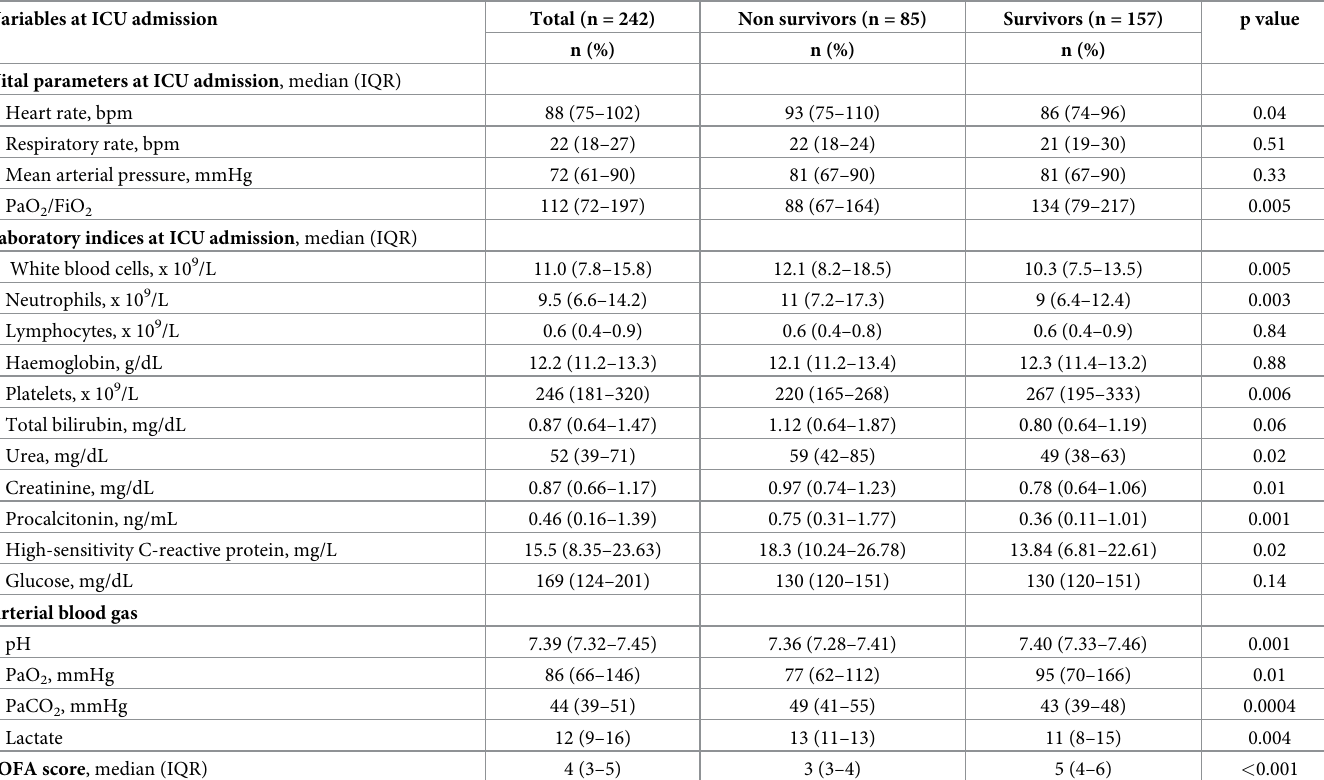
Table 2. Vital parameters, laboratory findings and treatments at ICU admission, data are reported as median, IQR.